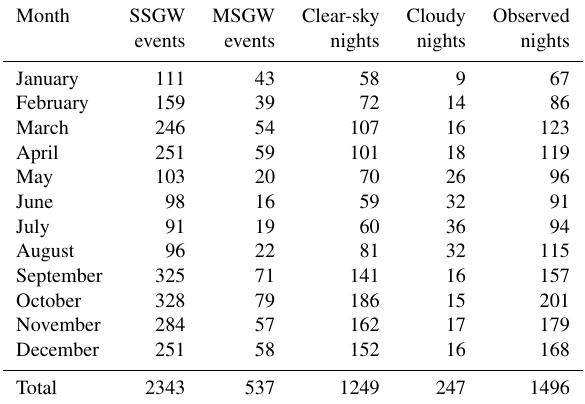
Table 2. The monthly distribution of the SSGW and MSGW events, clear-sky nights, cloudy nights, and observed nights during the pe- riod of 2000 to